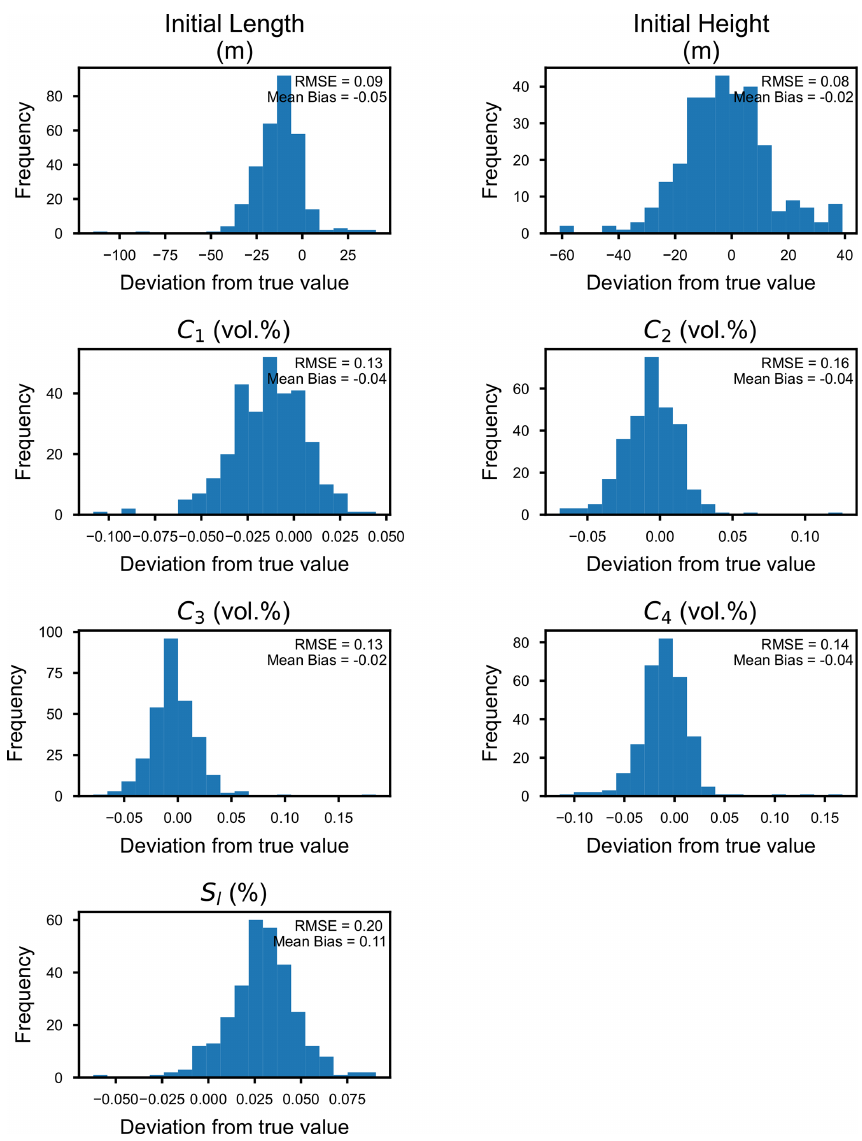
Figure 8. Histograms indicating the deviation of the predicted values from the true values.